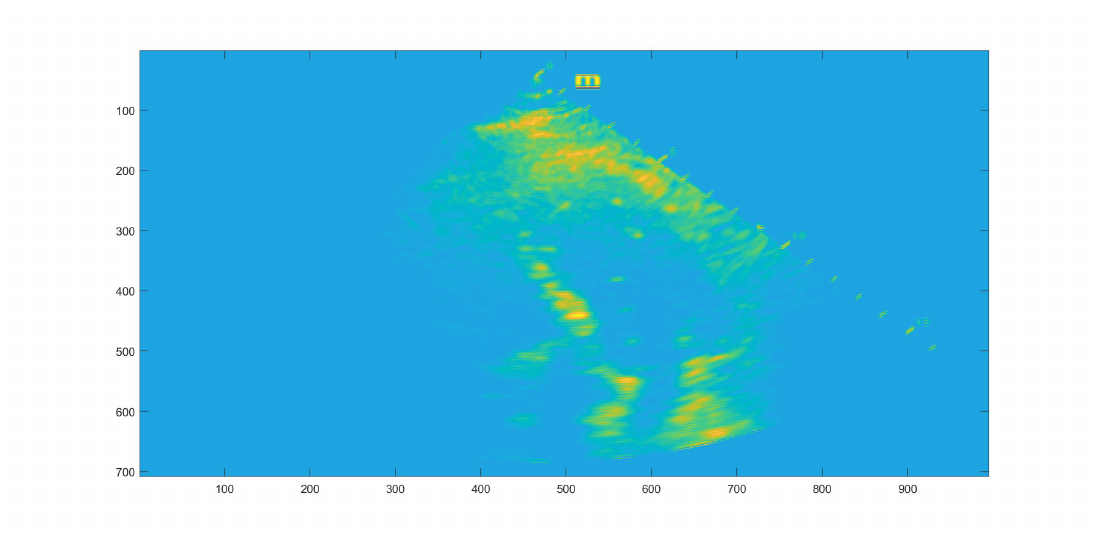
Figure 3. ROI after Gabor-like filter.